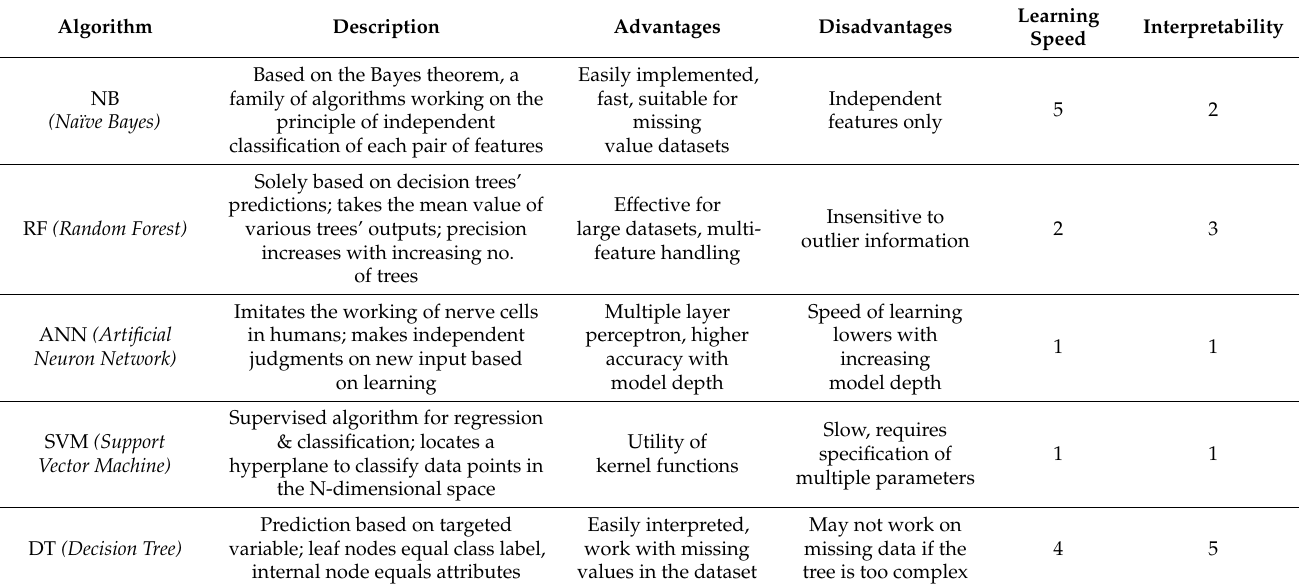
Table 2. Advantages and disadvantages of commonly used AI